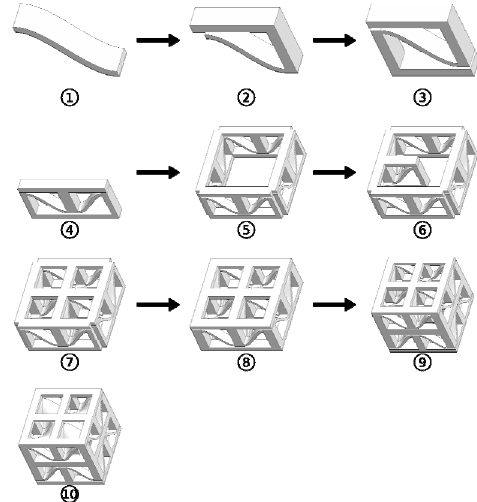
Figure 5. Designing of the CAD